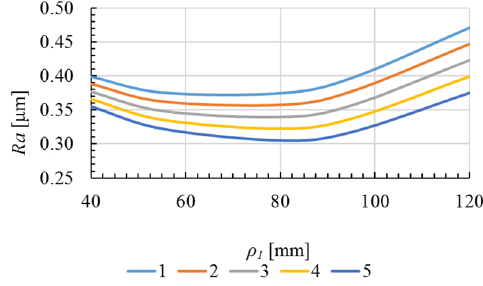
Figure 12. Effect of the lead angle α on the Ra roughness parameter in the machining of the convex surface: (1) ρ 1 = 30 mm, (2) ρ 1 = 122.5 mm, (3) ρ 1 = 215 mm, (4) ρ 1 = 307.5 mm, (5) ρ 1 = 400 mm.